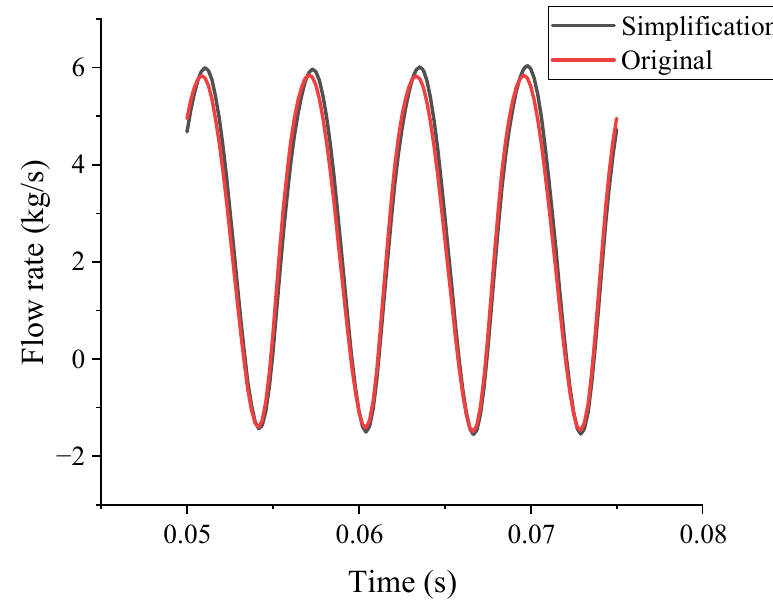
Figure 7. The original model simplified the outlet flow before and after.